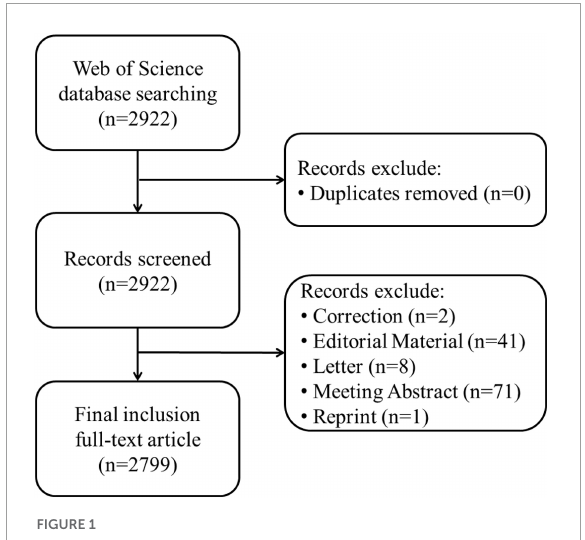
FIGURE1 Flowchart of including and excluding